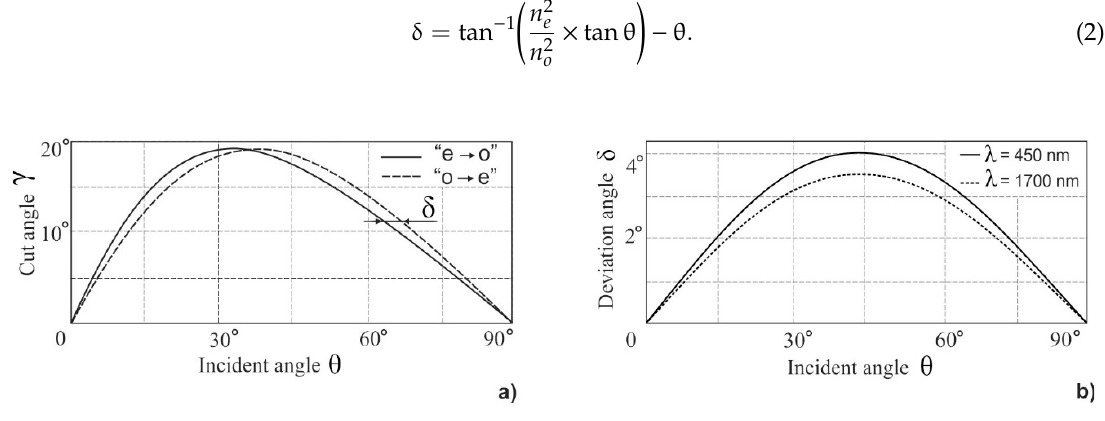
Figure 2. Relationship between angles γ and θ for wide-aperture diffraction in TeO 2 ( a ) and ( b ) deviation angle dependence δ ( θ ).